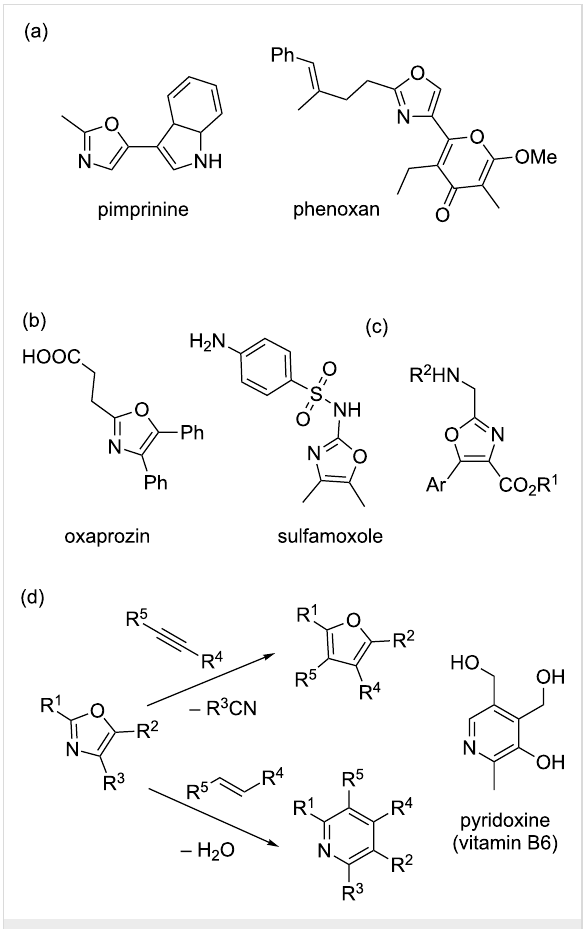
Figure 1: Examples of naturally occurring oxazoles (a); some drugs containing oxazole as the active moiety (b); general structure of fluo- rescent dipeptidomimetics derived from trisubstituted oxazoles (c); reactivity of the oxazole system as an azadiene (d).